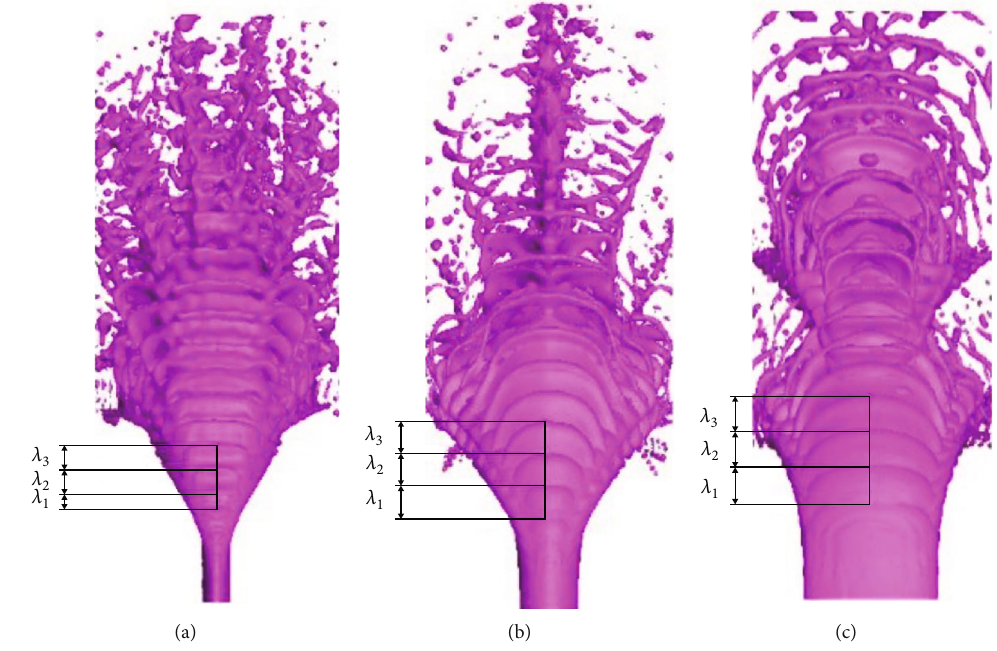
Figure 5: Measurement of surface wavelength for Case 1, Case 3, and Case